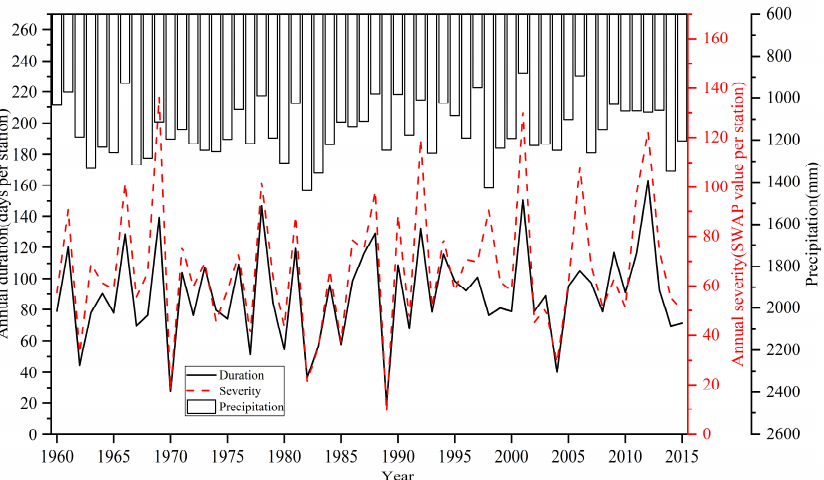
Figure 2. Temporal variation of annual precipitation, annual duration, and annual severity of ordinary drought events in Chongqing (1960–2015).